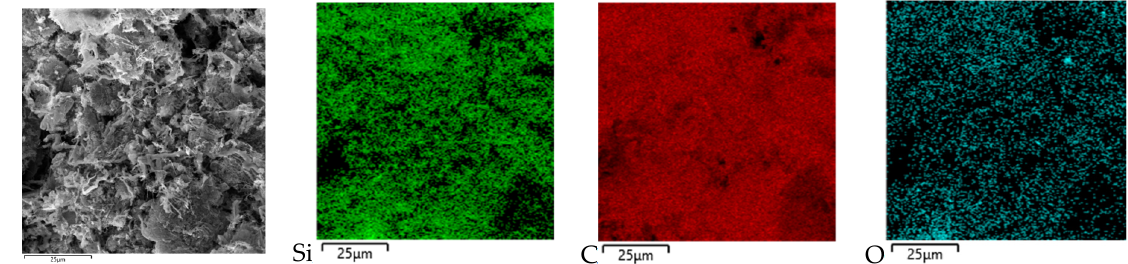
Figure 2. SEM-images and elements distribution in a C/SiC mixture after carbothermal synthesis and treatment in HF